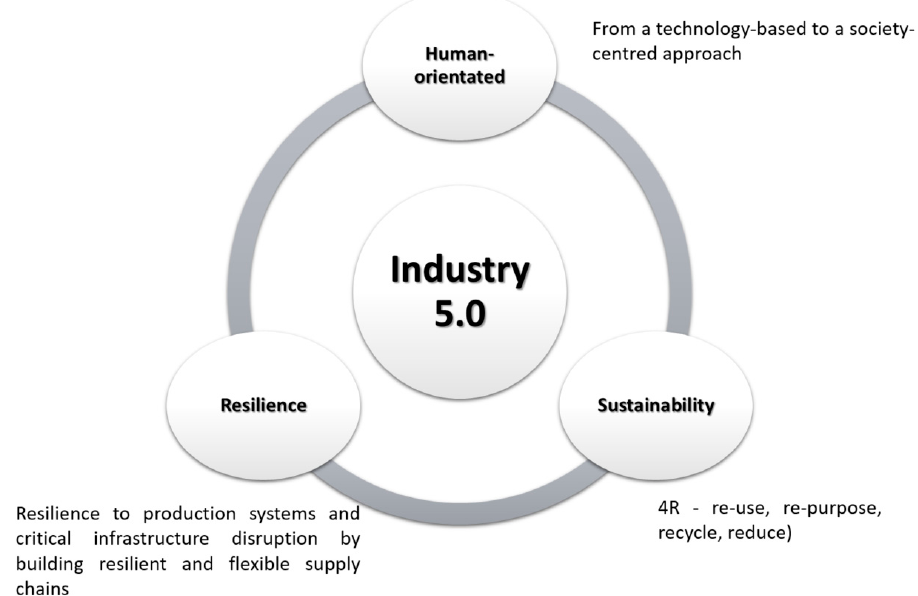
Figure 30. The concept of Industry 5.0. Source: own contribution based on [347].